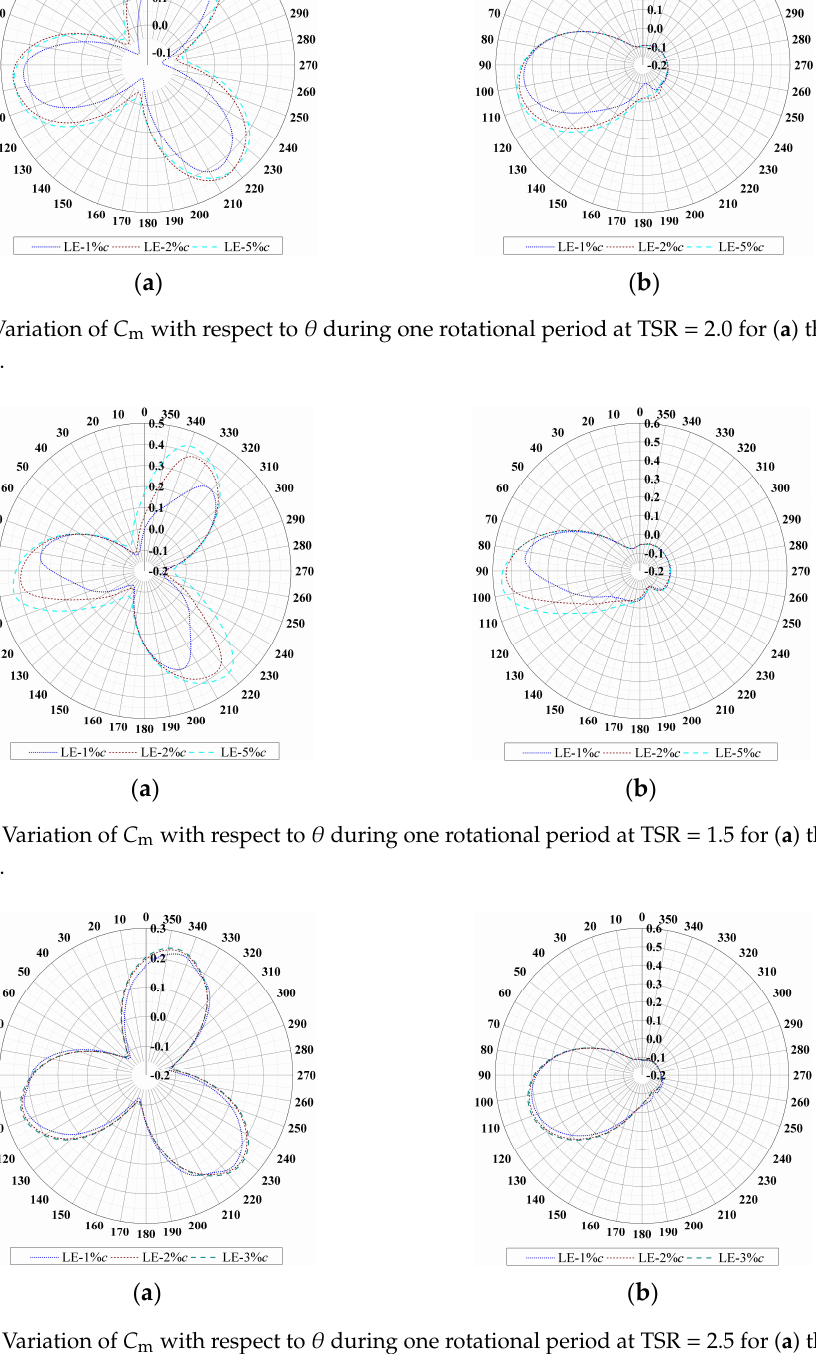
Figure 11. Variation of C m with respect to θ during one rotational period at TSR = 2.5 for ( a ) the rotor; ( b ) blade 1.